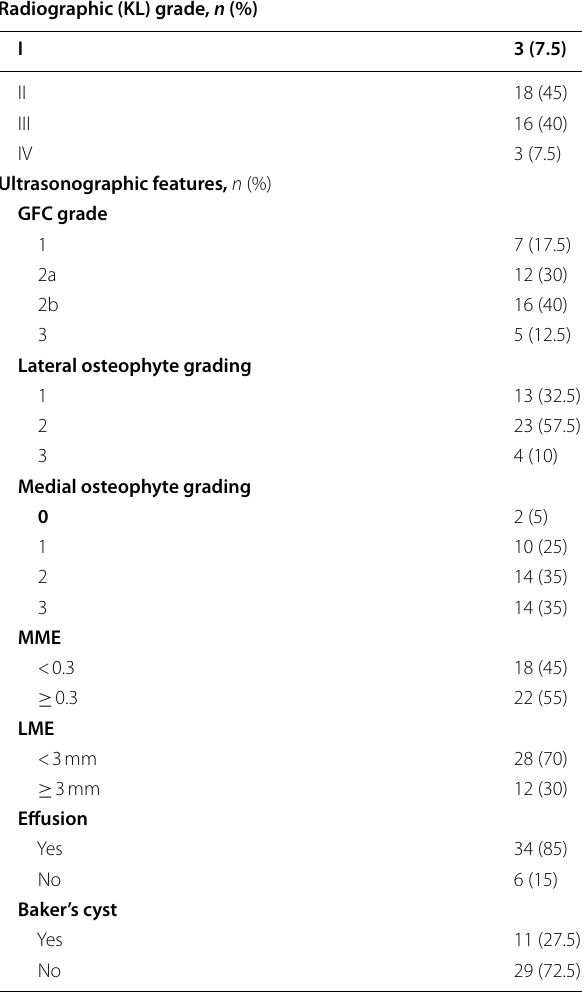
Table 2 Radiographic and US characteristics of the studied